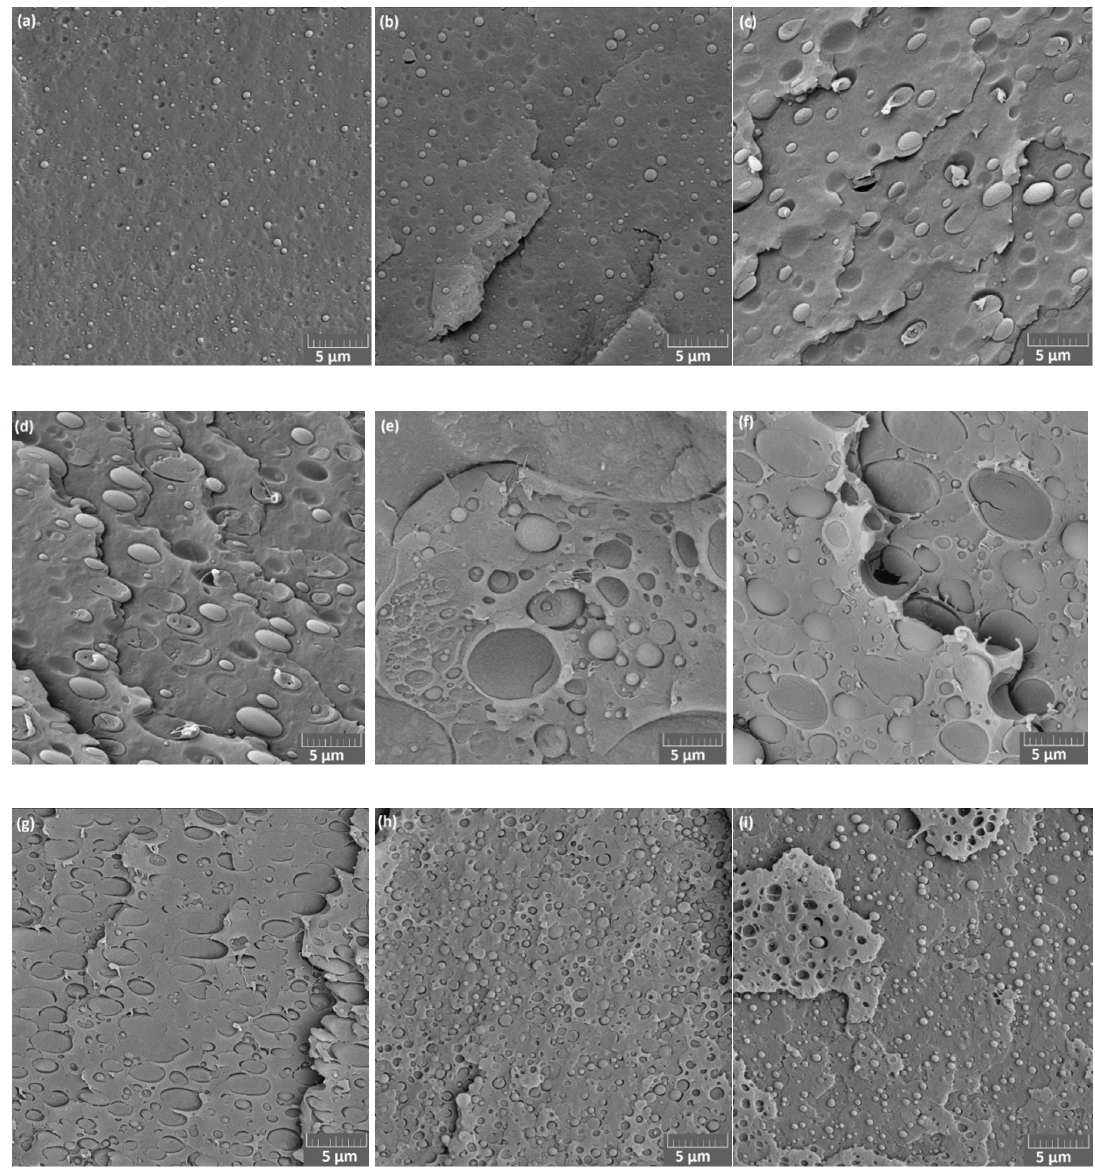
Figure 6. SEM of cryofractured surface of pressed panels (800 µm) made of PBAT/PLA blends with various weight ratios: ( a ) 90 / 10, ( b ) 80 / 20, ( c ) 70 / 30, ( d ) 60 / 40, ( e ) 50 / 50, ( f ) 40 / 60, ( g ) 30 / 70, ( h ) 20 / 80, various weight ratios: ( a ) 90/10, ( b ) 80/20, ( c ) 70/30, ( d ) 60/40, ( e ) 50/50, ( f ) 40/60, ( g ) 30/70, ( h ) 20/80, ( i ) 10 / ( i ) 10/90.